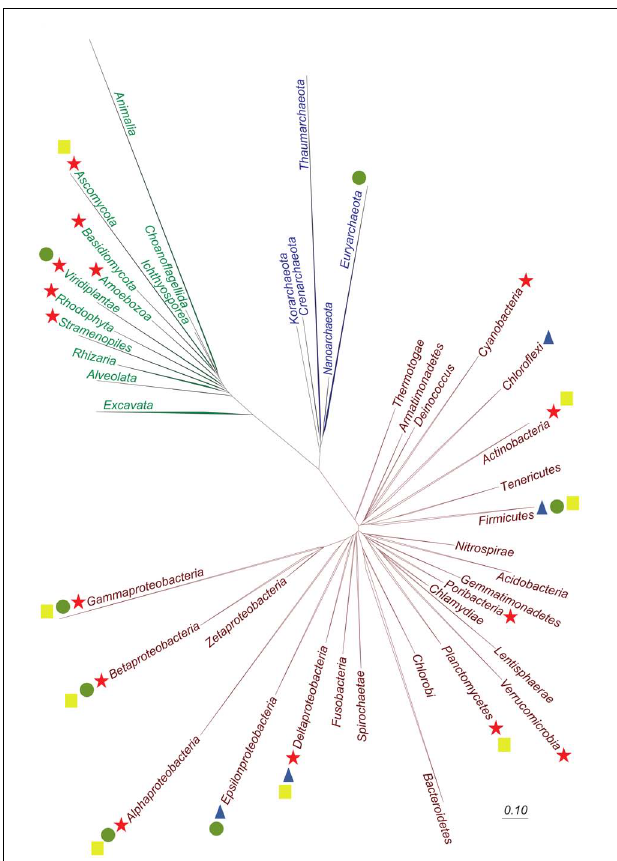
FIGURE 3 | Tree of life showing the phyla or classes for which key enzymes of microbial (de)chlorination processes have been detected. The tree of life was prepared from the Silva SSU Ref NR 115 database. The bar illustrates a distance of 0.1 substitutions per site. Organisms that carry aerobic haloalkane dehalogenases are indicated by a yellow square. Reductive dehalogenase-baring organisms are shown by the blue triangle, organisms with chlorate- and perchlorate-reducing enzymes by the green circle and halogenase-producing organisms by the red